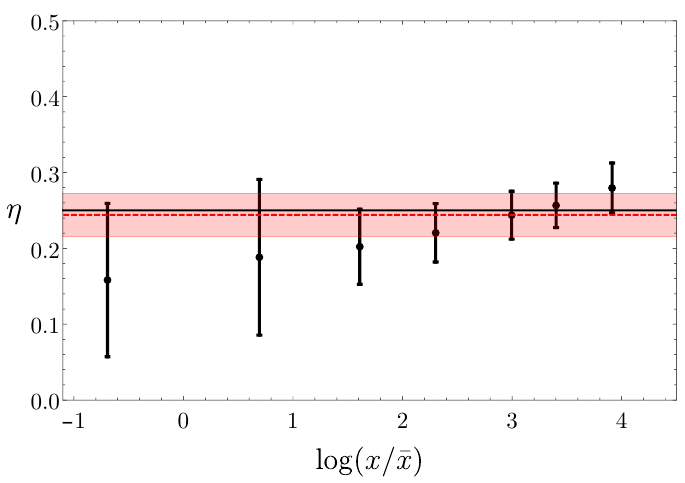
Figure 9 . The slope coe(cid:14)cient (cid:0) log[ T ( x; (cid:22) x )] = log( j x j = j (cid:22) x j ) of the normalized 2 point function computed by Borel resumming the series at g = g c , as a function of log( j x j = j (cid:22) x j ). At the critical point it is supposed to be constant in x and equal to the critical exponent (cid:17) . The black solid line represents the theoretically known value (cid:17) = 1 = 4.